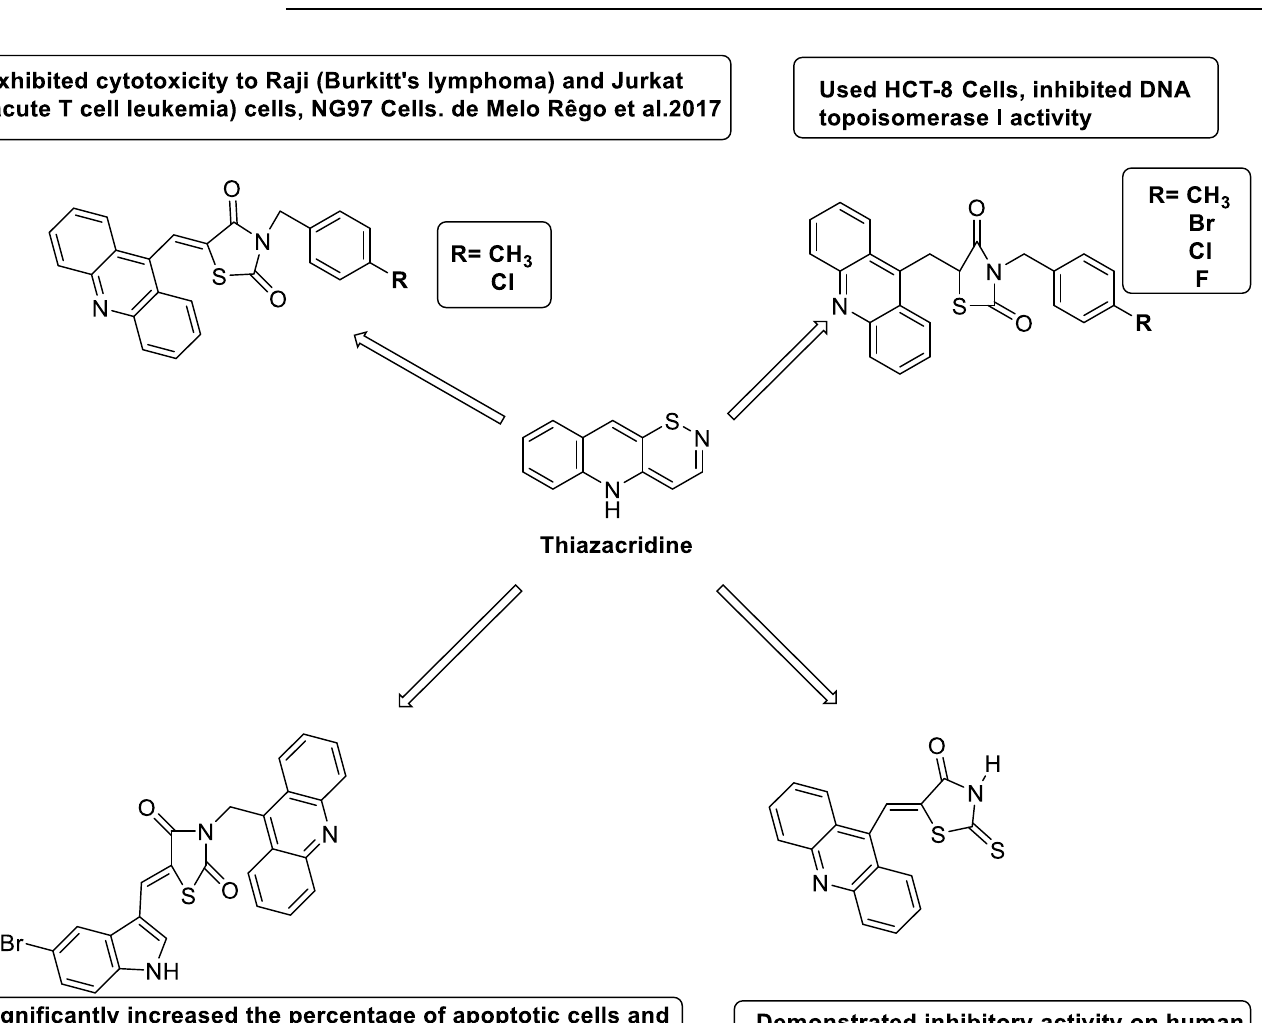
Figure 13. SAR of azaacridine derivatives as dual-target EGFR and Src kinase inhibitors. Table 15. Azaacridine as an anti-tumour agent.